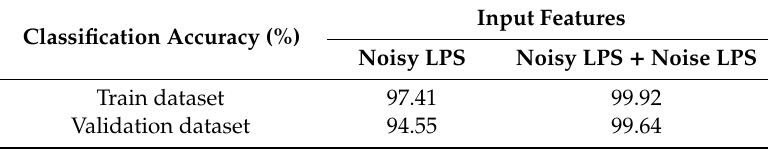
Table 1. Classification accuracy results in train and validation